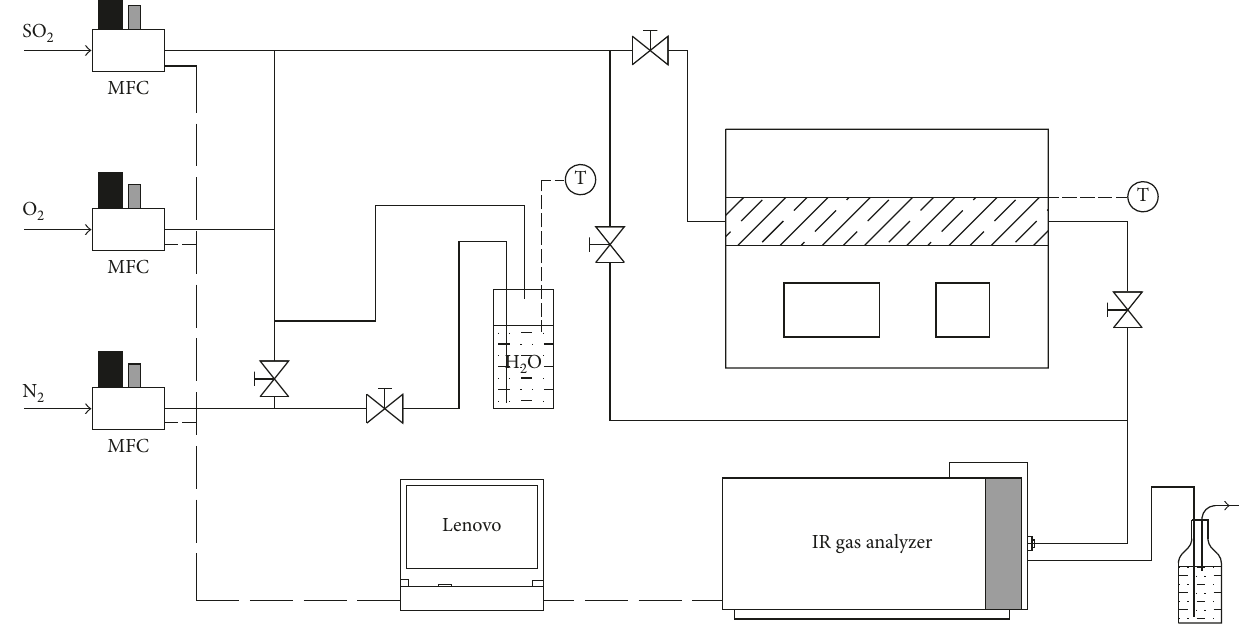
Figure 1: Schematic for device processing. MFC: mass flow controller; T: temperature controller.